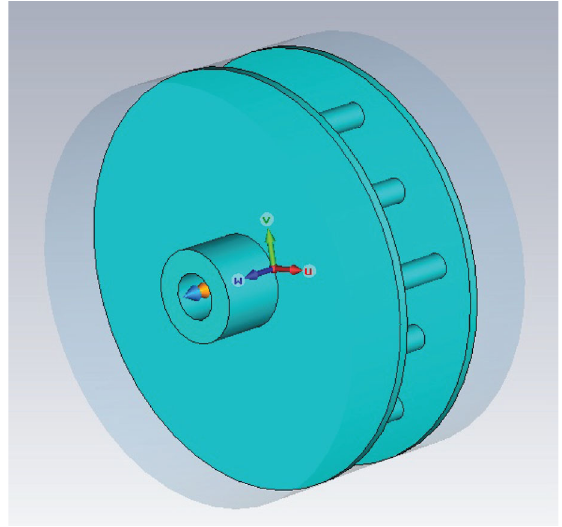
FIG. 6 (color online). CST M ICROWAVE S TUDIO geometry of a PBG resonator with the open sidewall and excited by a current source.